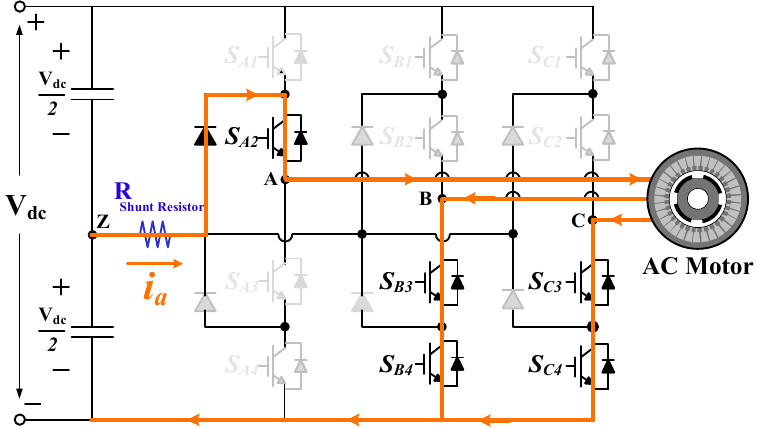
Figure 3. Current path of neutral shunt resistor when effective vector “O”, “N”, and “N” is applied to the inverter.